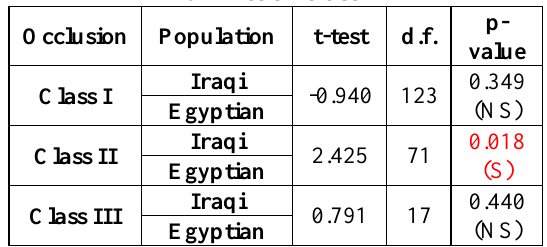
Table 3: Population difference for overall ratio